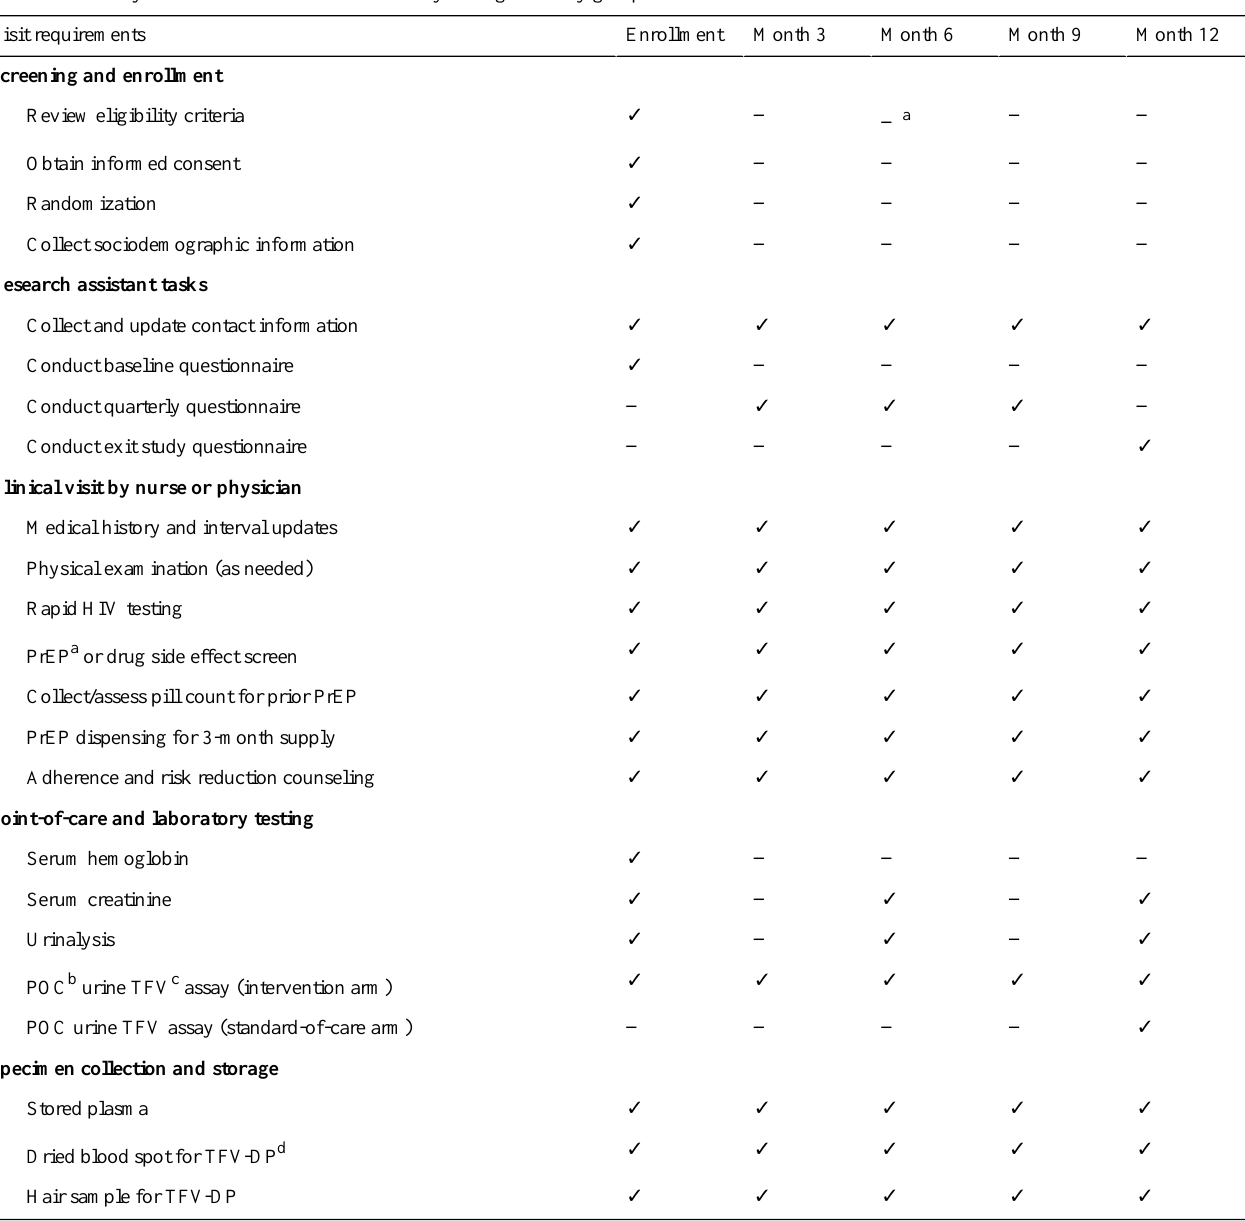
Table 1. Summary of the clinical visits and laboratory testing for study